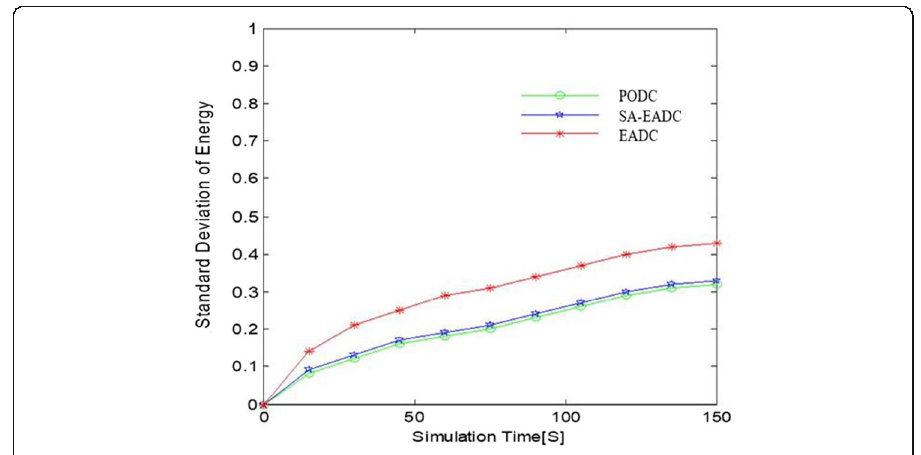
Fig. 9 Standard deviation of residual energy (context